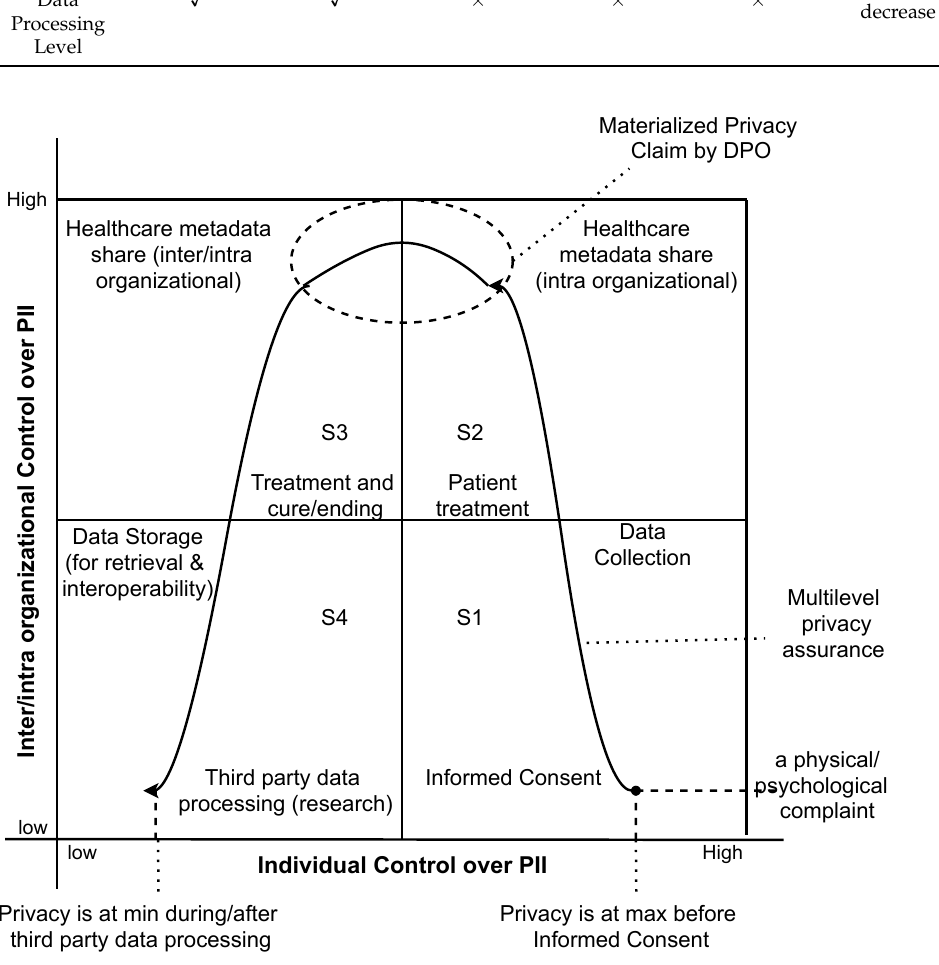
Figure 11. Multilevel Privacy Assurance